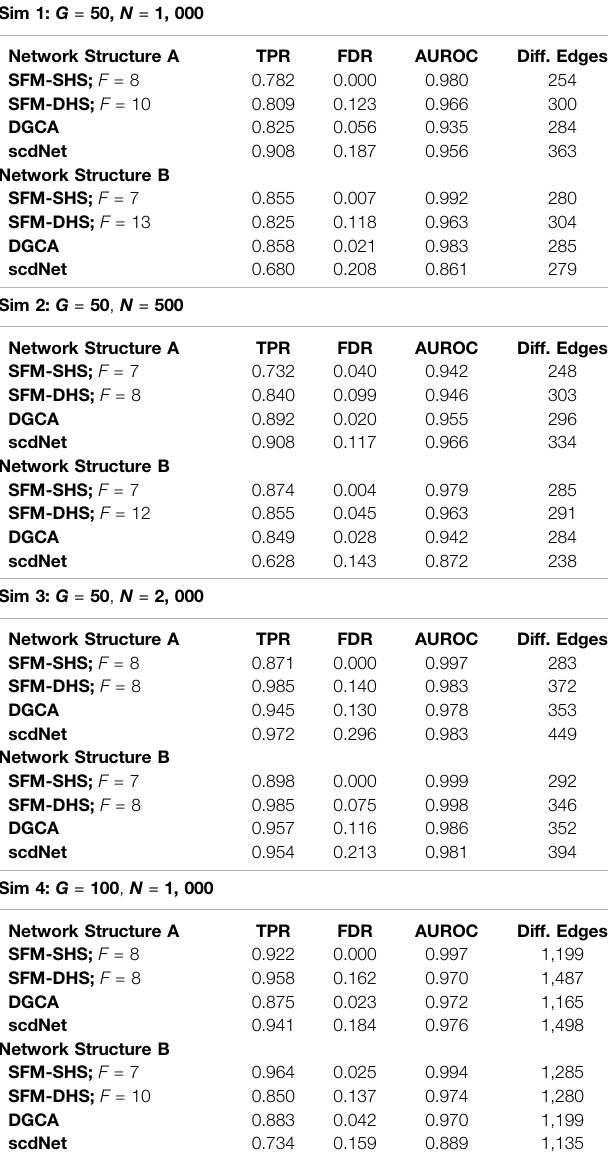
TABLE 1 | Comparison of the “ true ” differences between networks and the estimated differences between networks in the simulation studies for each differential network method. Results displayed for SFM-SHS and SFM-DHS are from the bootstrap estimation procedure. In Sim 1 – 3, there are 325 “ true ” differential edges and in Sim 4 there are 1, 300 “ true ” differential